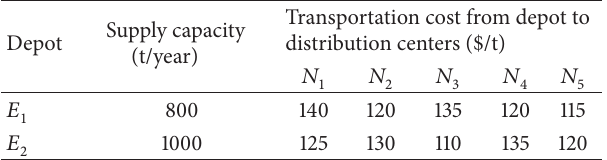
Table 1: Supply capacities and transportation cost rate of depots.